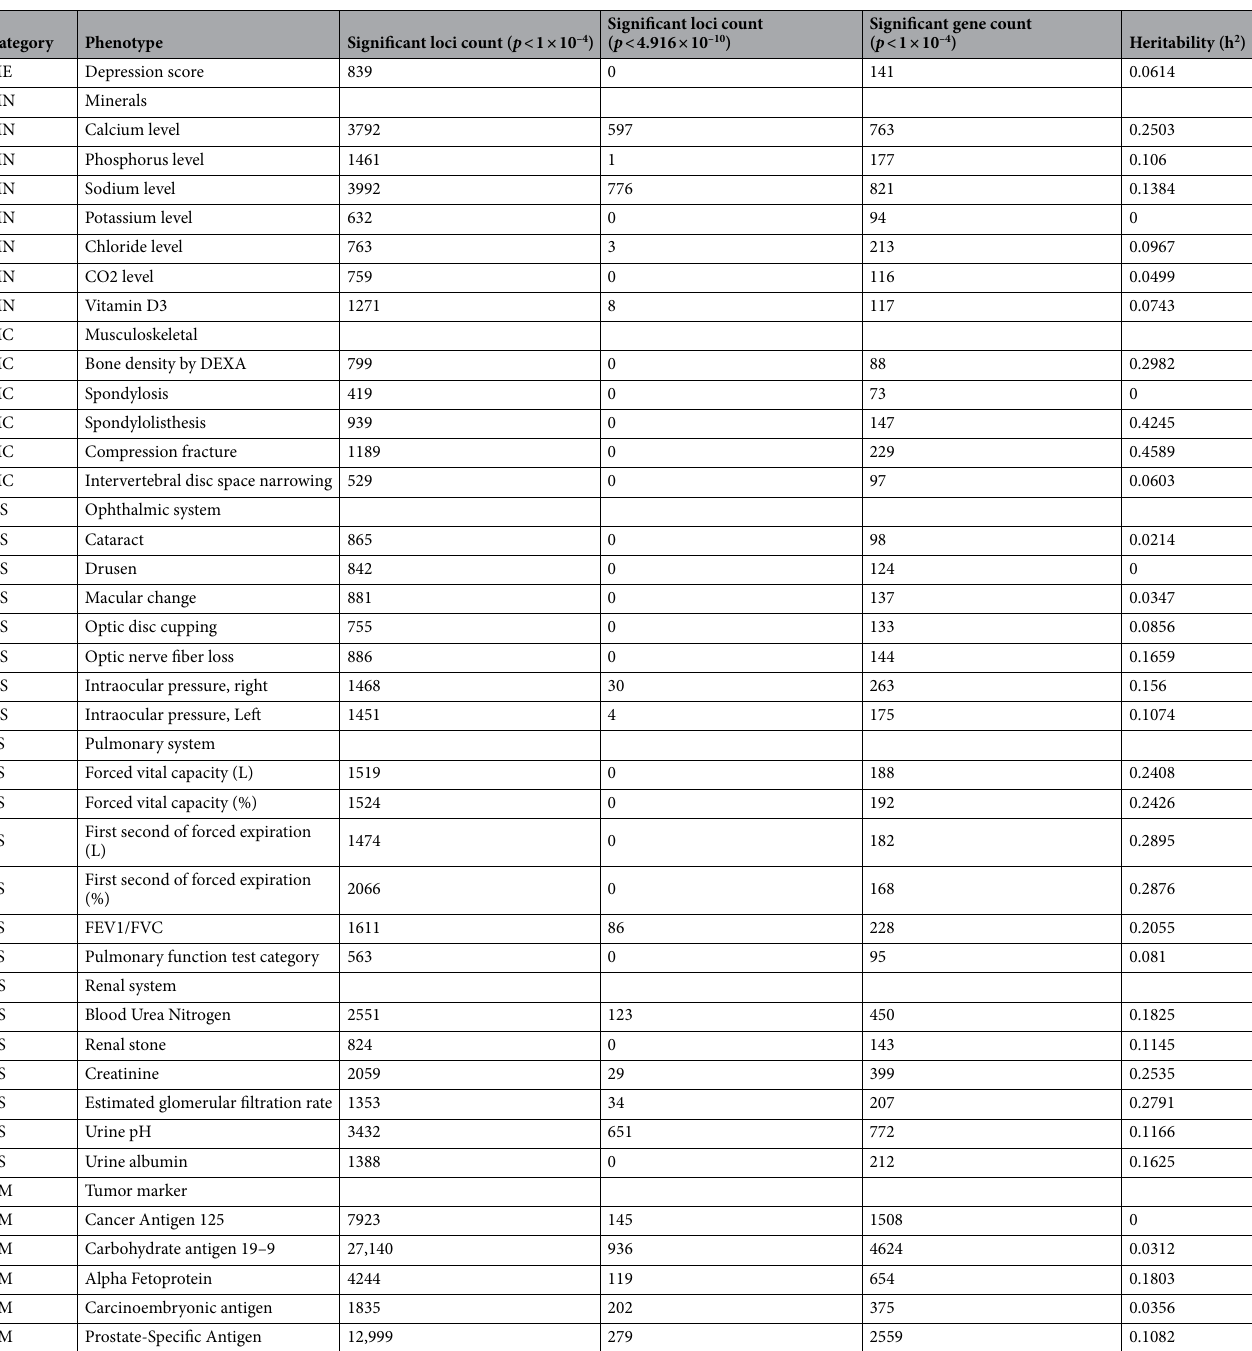
Table 1. Overview of the studied